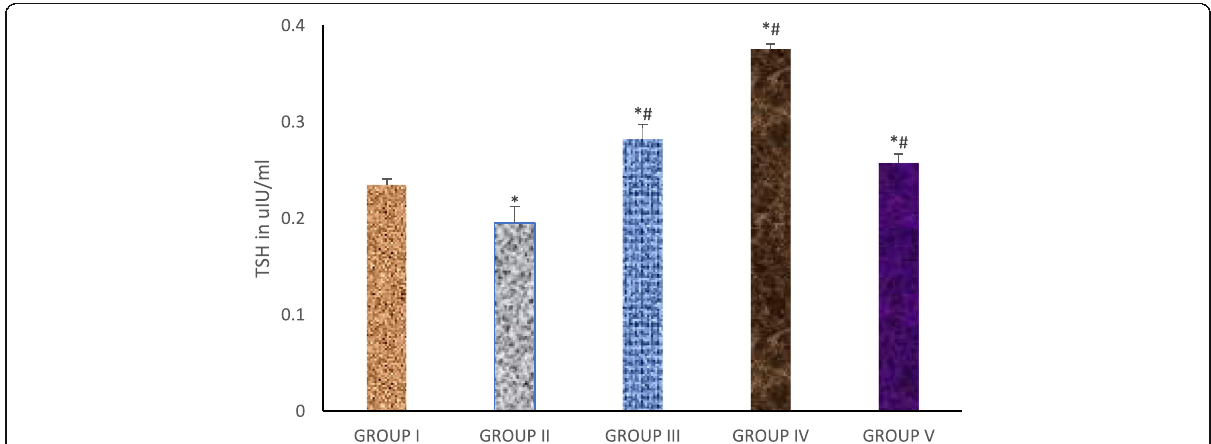
Fig. 6 Effect of MLVA on Thyrotropin (TSH) Hormone of rats treated with nitrobenzene. Data are given as mean ± SD of rats per group. n = 6. MLVA: methanolic leaf extract of Vernonia amygdalina , *: Values differ significantly from group I (control) ( P < 0.05). #: Values differ significantly from group